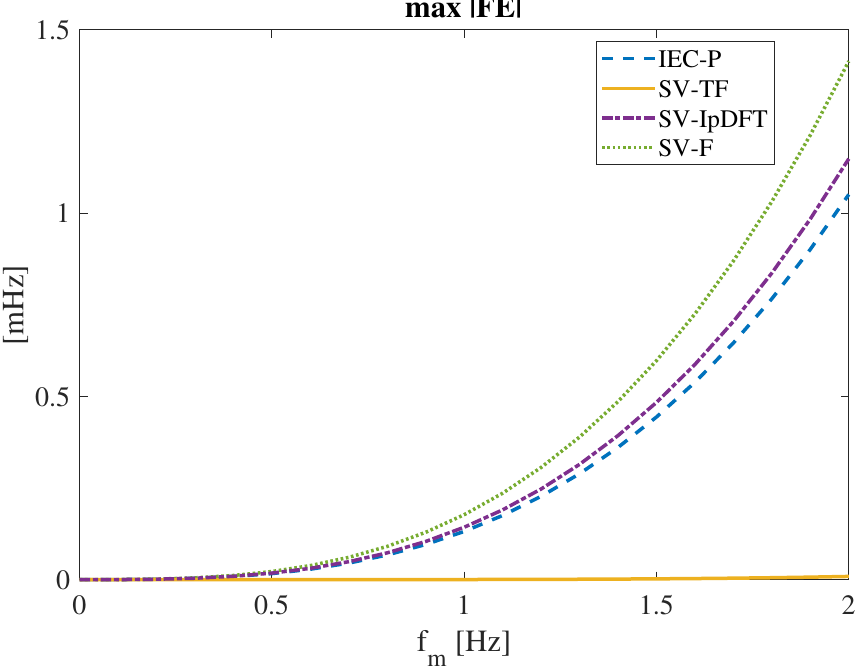
Figure 17. Maximum TVE results under phase-angle modulations with modulation frequency f m .